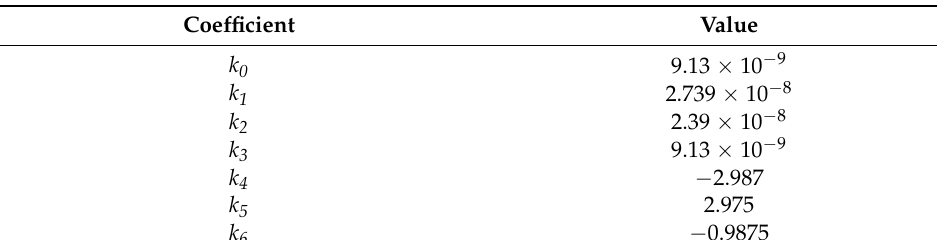
Table 1. Digital filter coefficients.